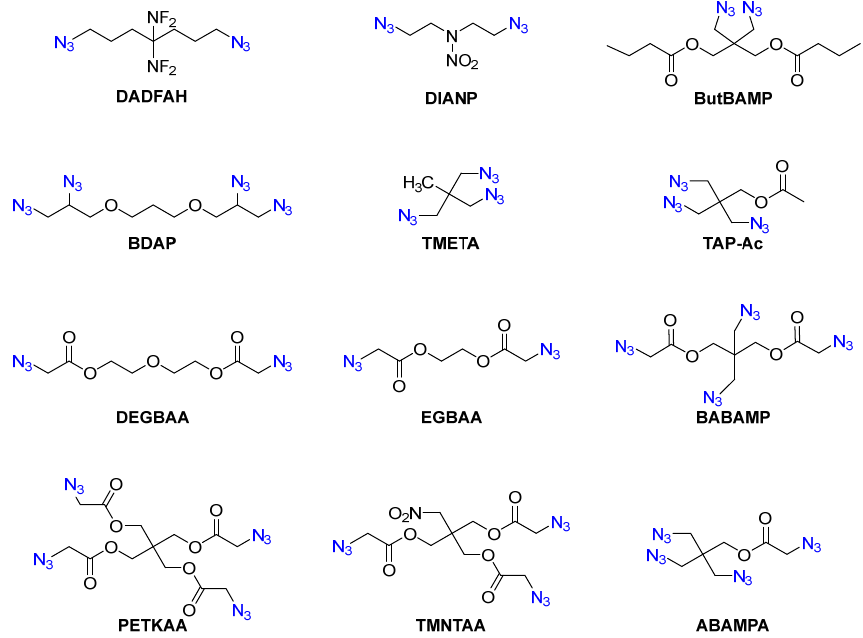
Figure 1. Lines 1 and 2: Azido energetic plasticizers for gun and rocket propellants with different functional groups. Lines 3 and 4: Selected structures of azido acetate esters. From left to right: 1,7 ‐ diazido ‐ N , N , N ’, N ’ ‐ tetrafluoro ‐ 4,4 ‐ heptanediamine ( DADFAH ), 1,5 ‐ diazido ‐ 3 ‐ nitrazapentane ( DIANP ), 2,2 ‐ bis(azidomethyl)propane ‐ 1,3 ‐ diyl dibutyrate ( ButBAMP ), bis(2,3 ‐ diazidopropylene